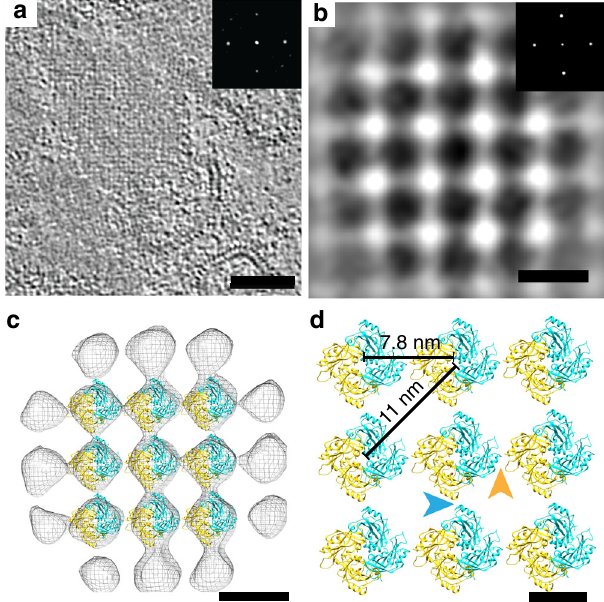
Fig. 2 MeV M protein forms a 2D paracrystalline array. a Tomographic slice showing a representative M array from Edm MeV-infected HeLa cells. Inset is the power spectrum indicating a four-fold symmetric structure with 7.8 nm spacing between subunits. b Sub-volume average of the M protein array indicates an improved SNR structure with regular spacing. Black is density. c Model fi tting of the NDV M dimer into the averaged MeV M array density. Cyan and gold represent each monomer of the NDV M dimer. d The enlarged view of ( c ), with blue and gold arrowheads indicate the two dimer interfaces. Scale bars are 100 nm ( a ), 10 nm ( b , c ), and 5 nm ( d